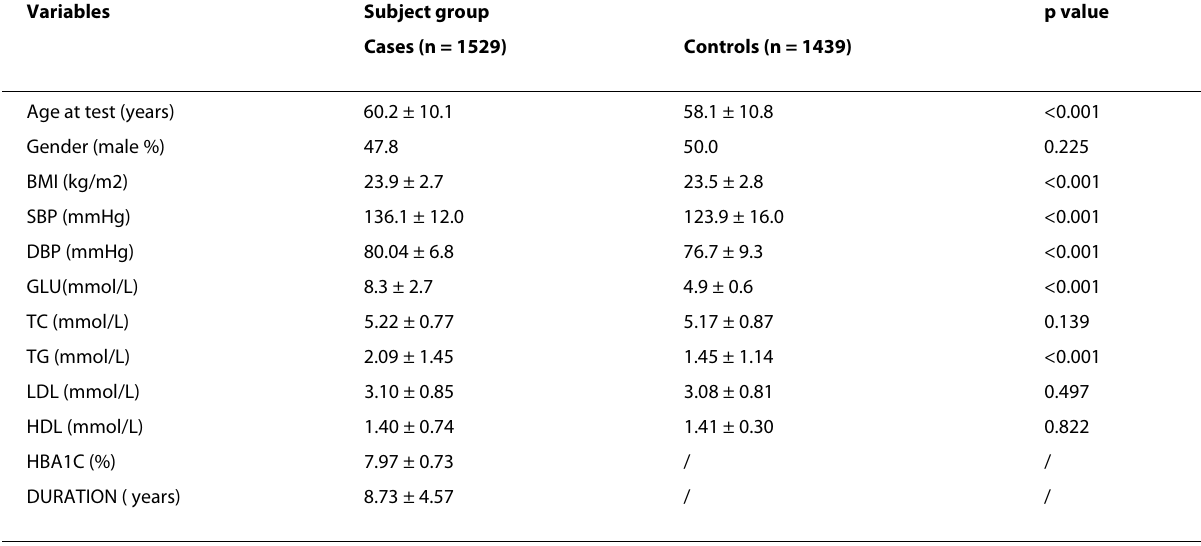
Table 1: Characteristics of cases and controls for age and ethnicity